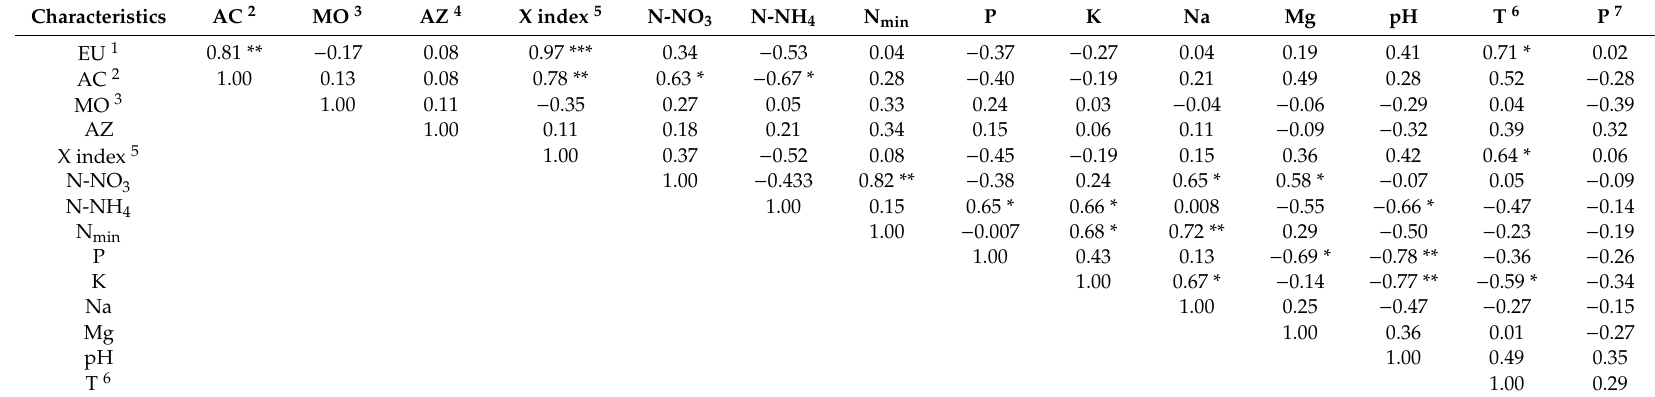
Table A3. Pearson correlation matrix between microbiological and chemical characteristics of pasture soil under grazed system, n = 12. Characteristics